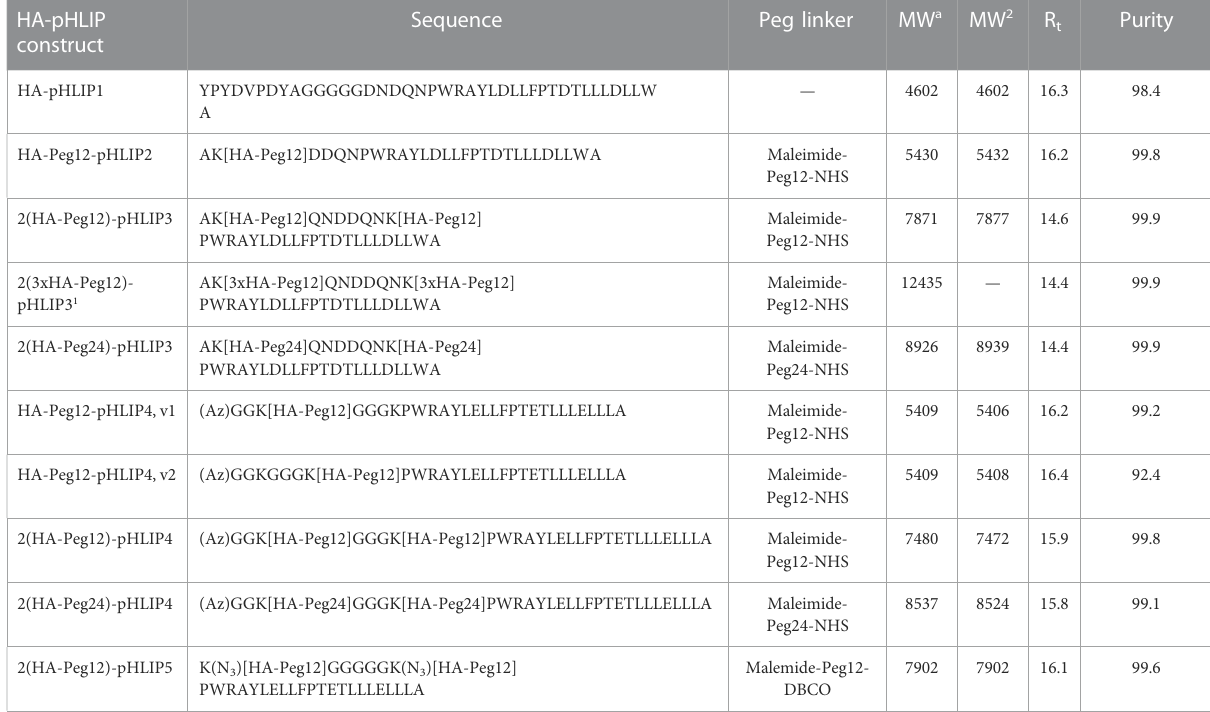
TABLE 1 List of all HA-pHLIP constructs used in this study. The conjugated molecules are shown in bold. Az is the 5-Azido-pentanoyl and K[N 3 ] is azidolysine. The calculated molecular weight (MW c ) andmolecular weight measured by masspec (MW m ), retention time (R t ) and purity(%) established by analytical HPLC are